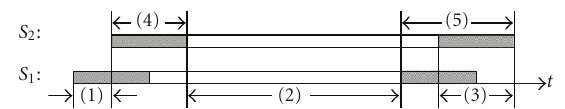
Figure 2: Fast algorithm of instantaneous parameters computation.